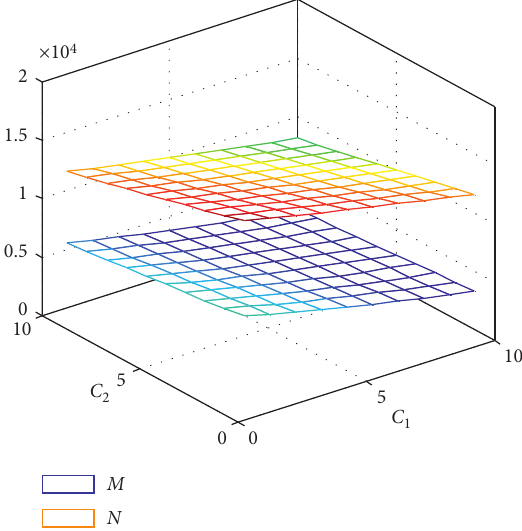
Figure 5: CL platform’s profits under decentralized and centralized decision-making.